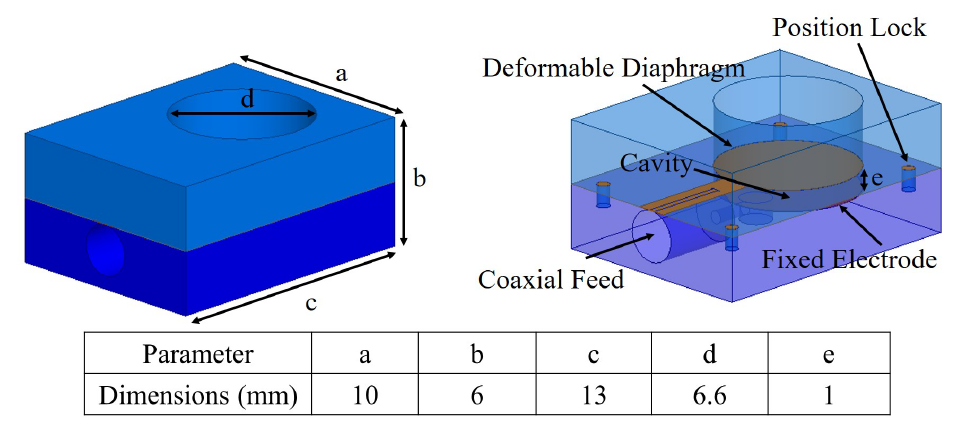
Figure 4. Fully assembled 3D printed pressure sensor with component annotation and dimensions.